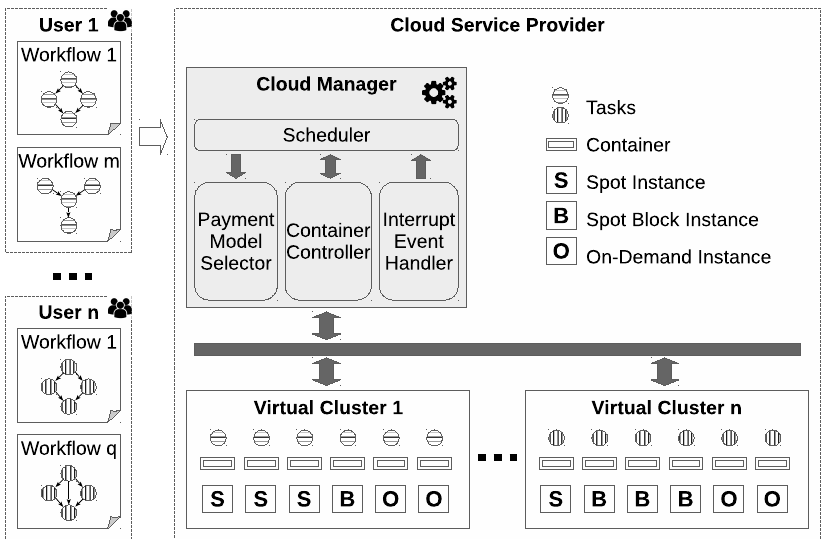
Figure 1. Cloud workflow scheduling onto reliable computing